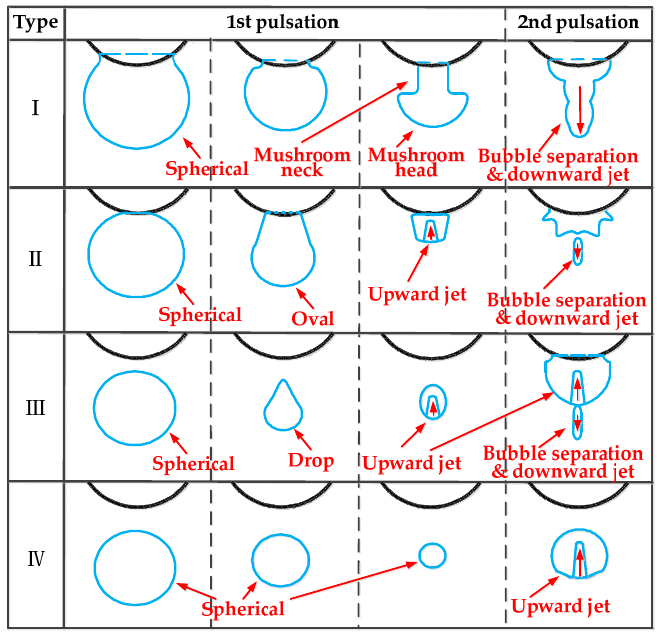
Figure 14. Bubble morphological change descriptions for types I–IV.